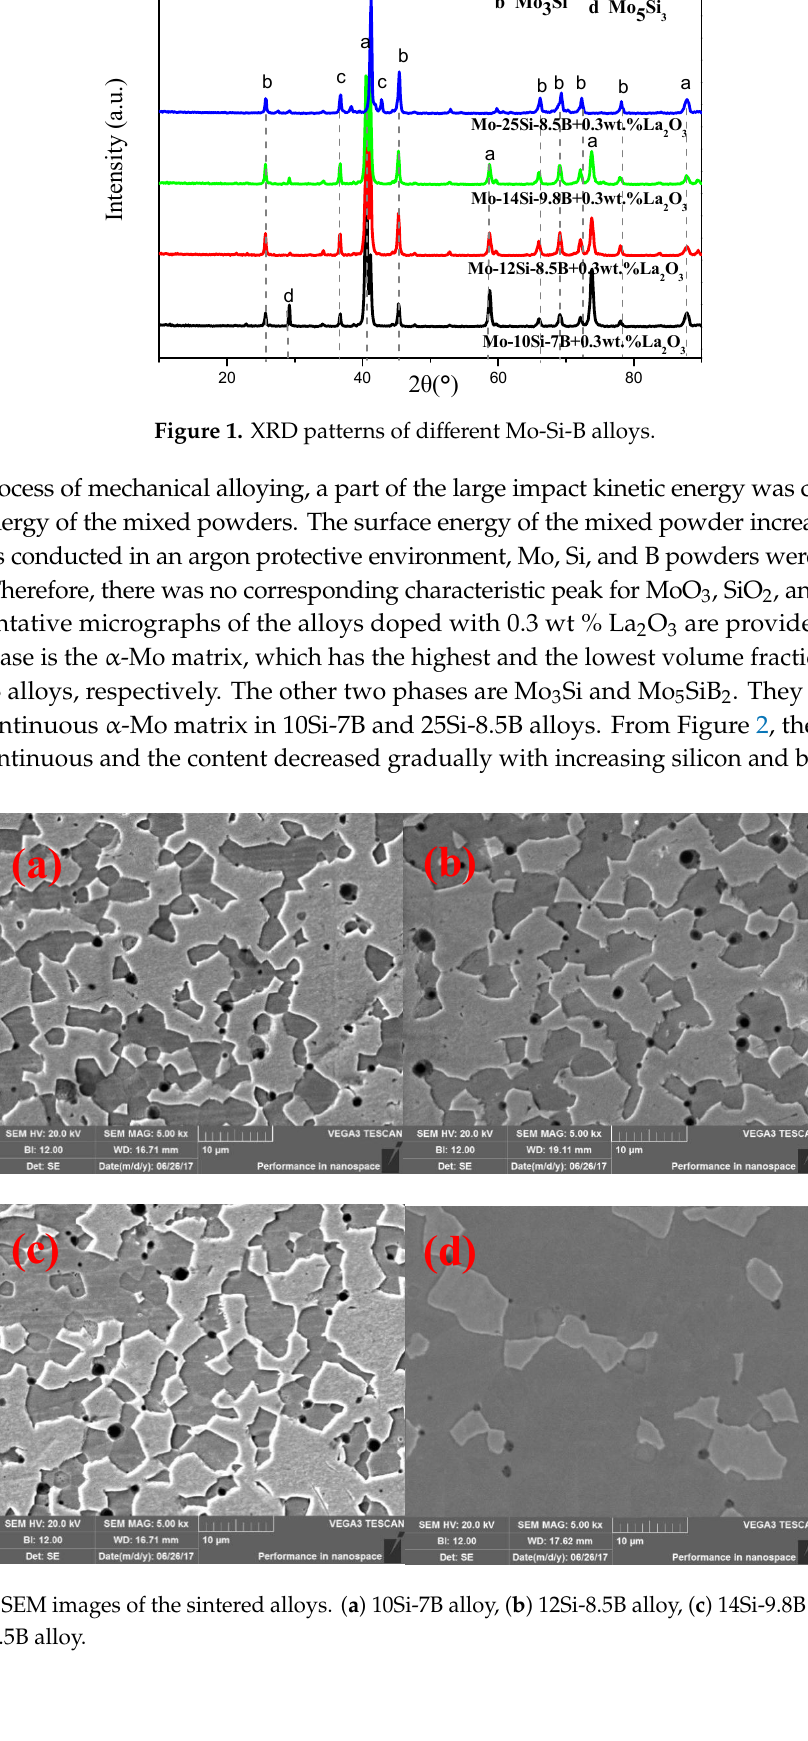
Figure 1. XRD patterns of different Mo-Si-B alloys.